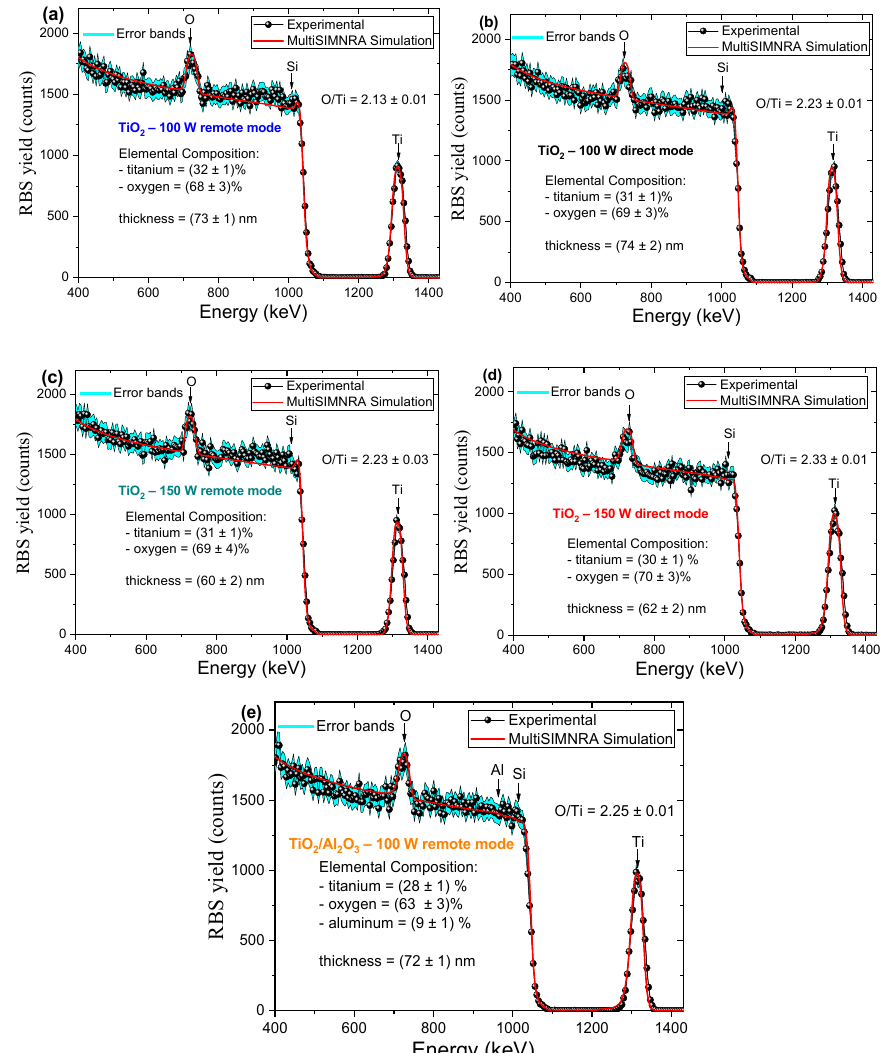
Figure 3. Experimental, simulated RBS spectra and data error bands for PEALD TiO 2 films deposited under different conditions: ( a ) 100 W in remote mode, ( b ) 100 W in direct mode, ( c ) 150 W in remote mode, ( d ) 150 W in direct mode and ( e ) 100 W in remote mode (TiO 2 /Al 2 O 3 nanolaminate). The precision was fixed in the MultiSIMNRA, at 10 − 7 , with the error bars in the simulated RBS spectra being smaller than the line size.